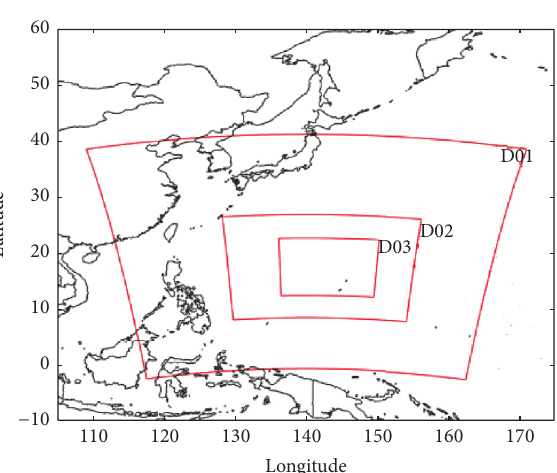
Figure 5: WRF domains for the super typhoon Phanfone (2014) D01 (27 km); D02 (9km); and D03